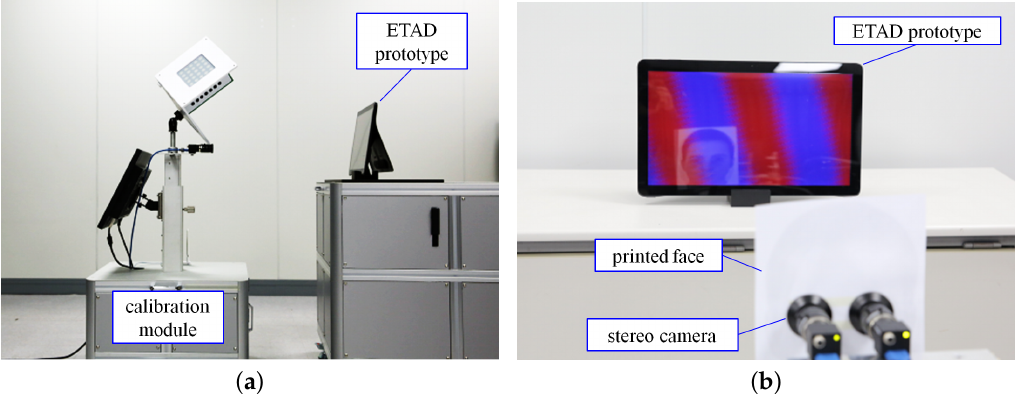
Figure 10. Calibration process: ( a ) calibration process using the calibration module; and ( b ) verification process using a stereo camera with a fake facial